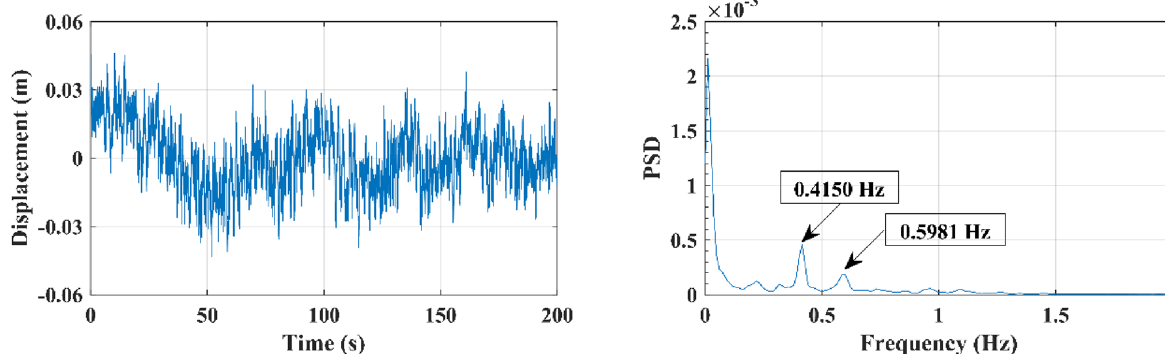
Fig. 10 GNSS signal and its PSD function